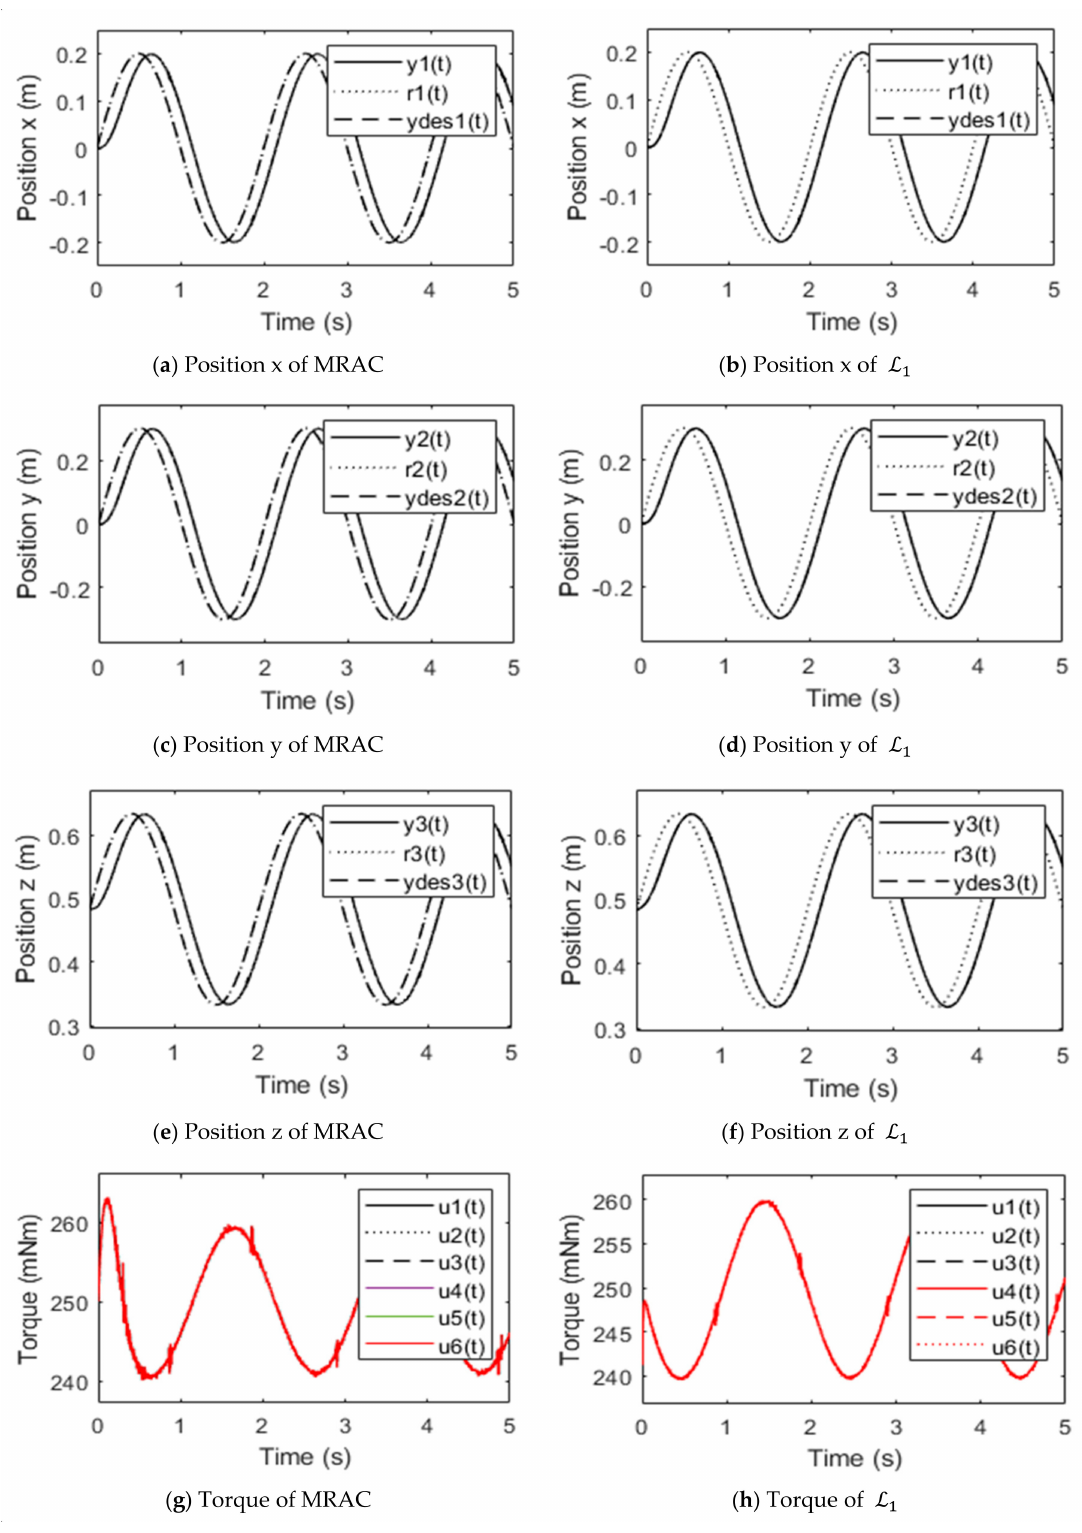
(cid:2) 0.2 sin ( π t ) , 0.3 sin ( π t ) , 0.48 + 0.14 sin ( π t ) , π